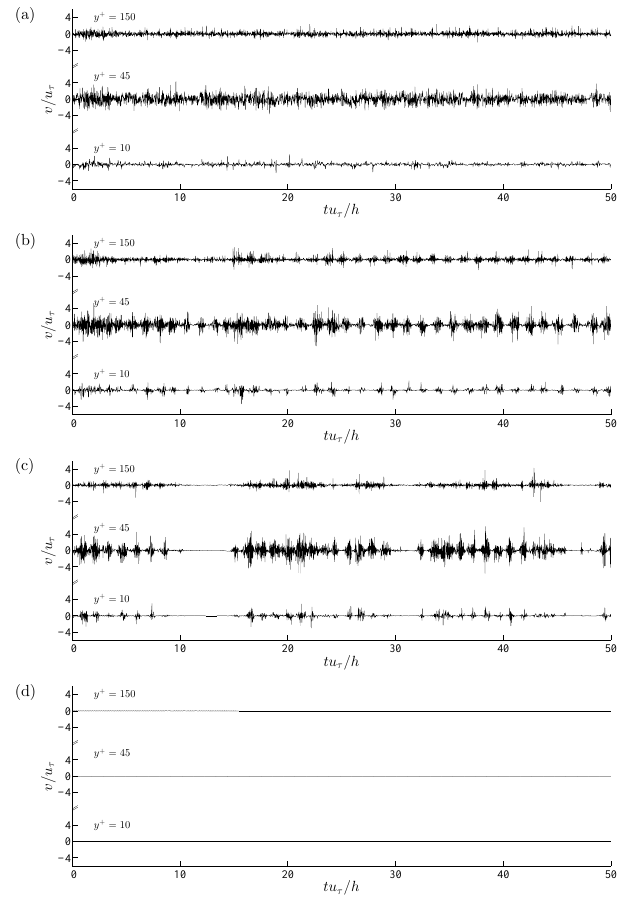
Figure 4. Time series of vertical velocity in the channel with differ- ent Ri τ ( Re τ = 180). (a) Ri τ = 30, (b) Ri τ = 120, (c) Ri τ = 240, and (d) Ri τ =